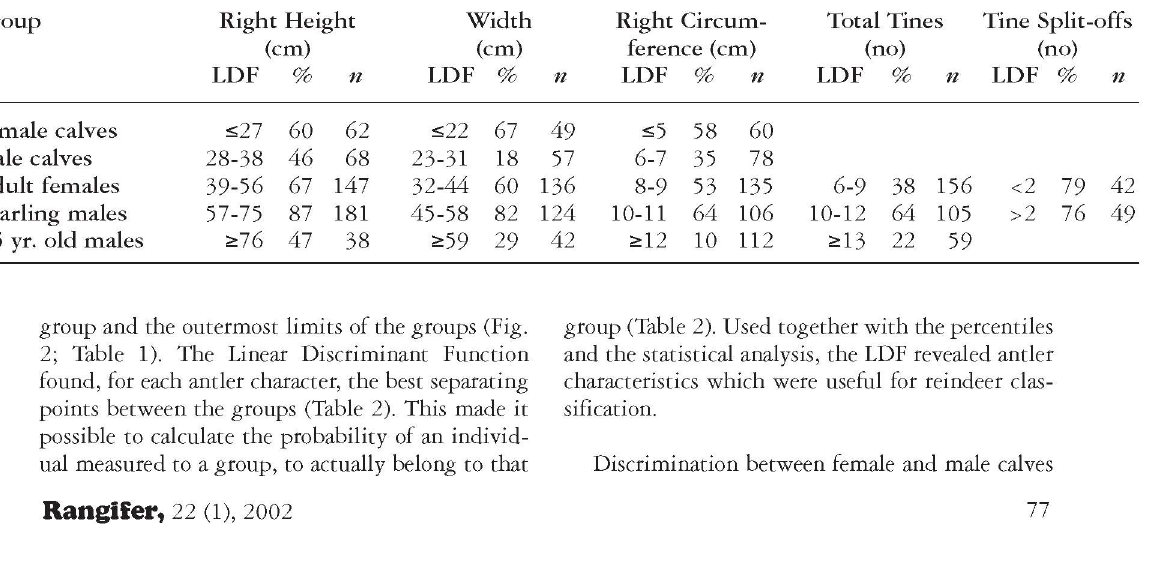
Table 2. Measurements for best reindeer classification according to the Linear Discriminant Function (LDF). The test rounds all values to whole numbers. The percentages (%) are the possibilities of an individual measured to a group to actually belong to that group. n is the number of individuals from all groups that classify in the sug¬ gested classification